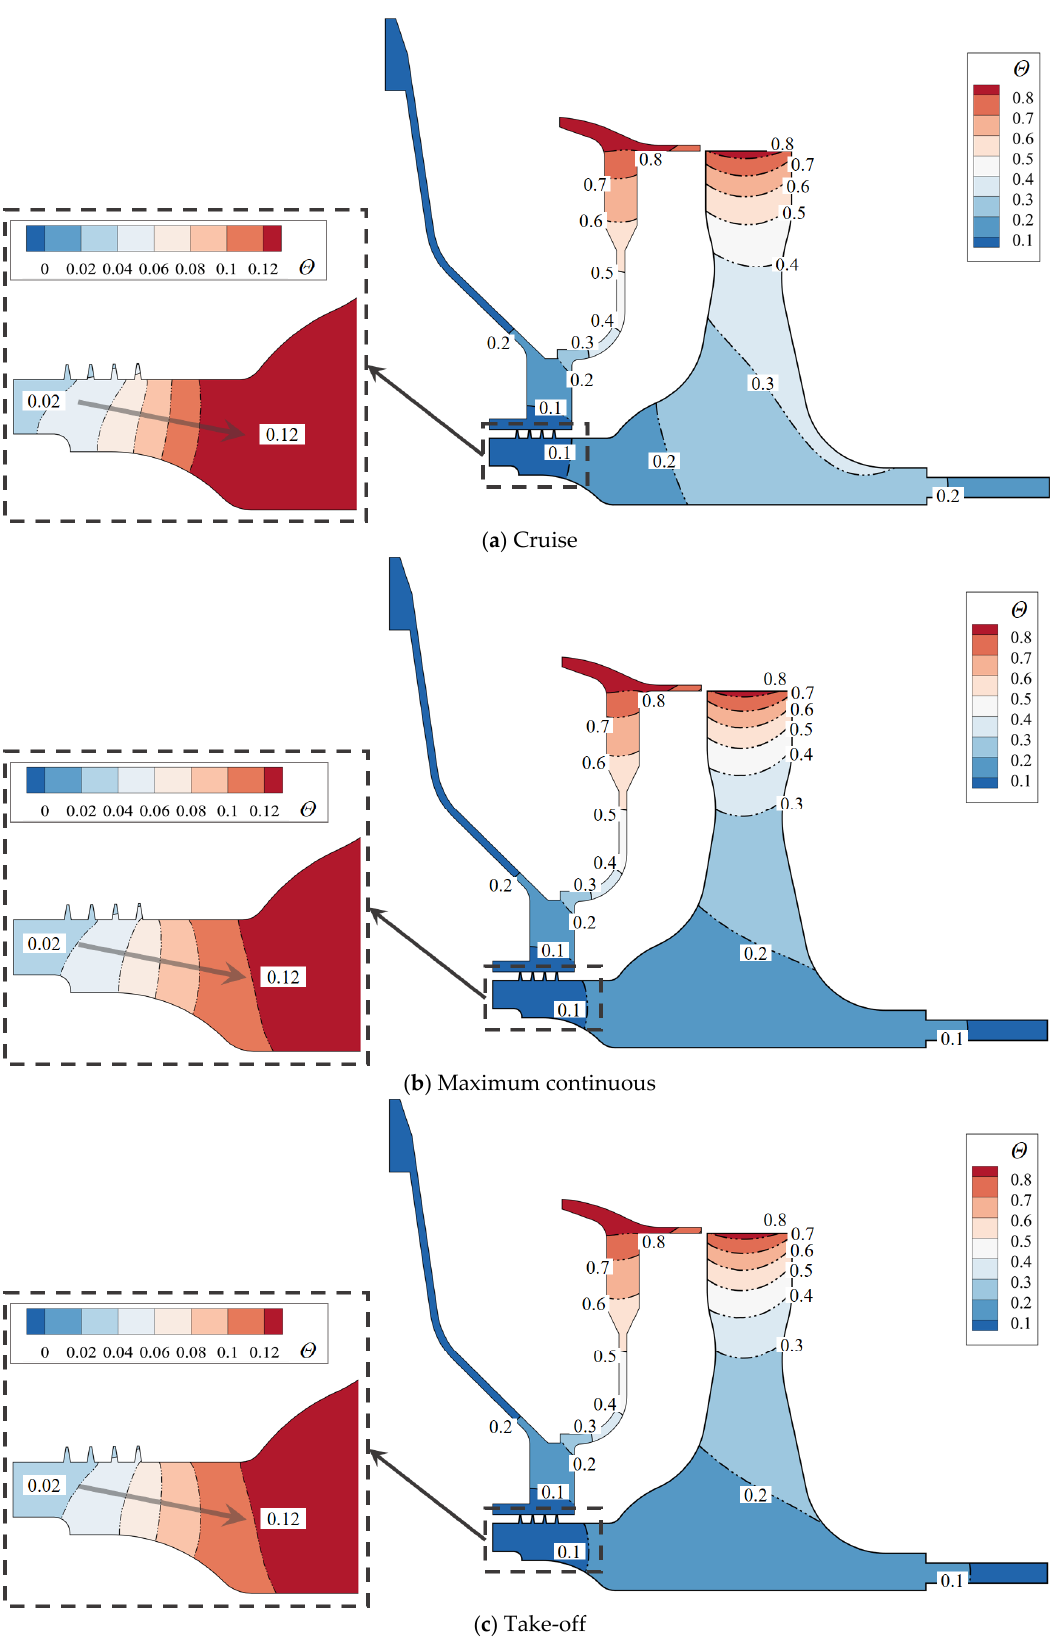
Figure 11. Distributions of dimensionless metal temperature.